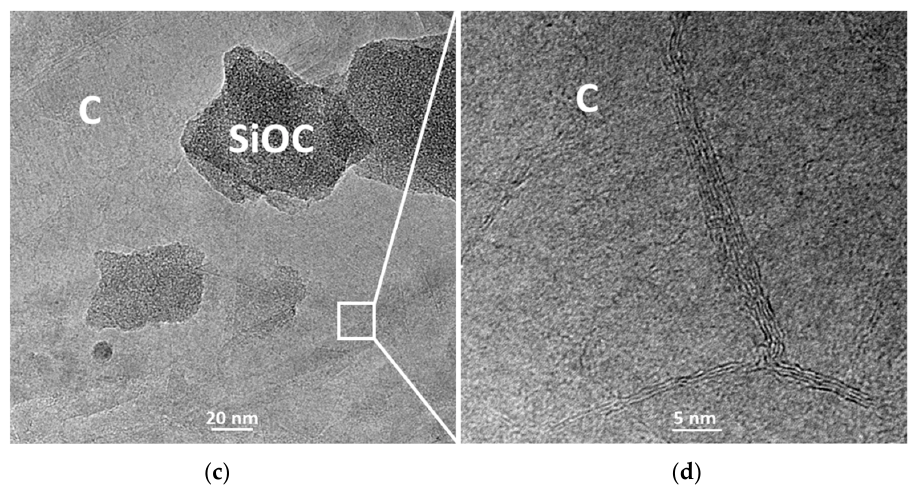
Figure 5. TEM images of: ( a ), ( b ) SiOC PhTES and ( c ), ( d ) SiOC PhTES /C10g samples.